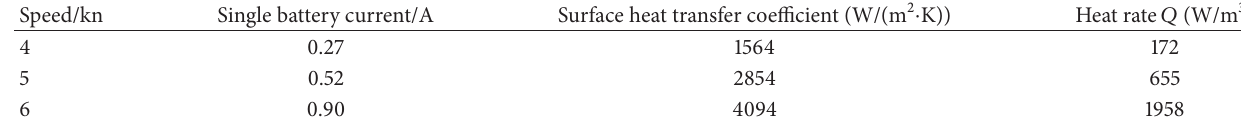
Table 4: Battery performance parameters at different speeds.